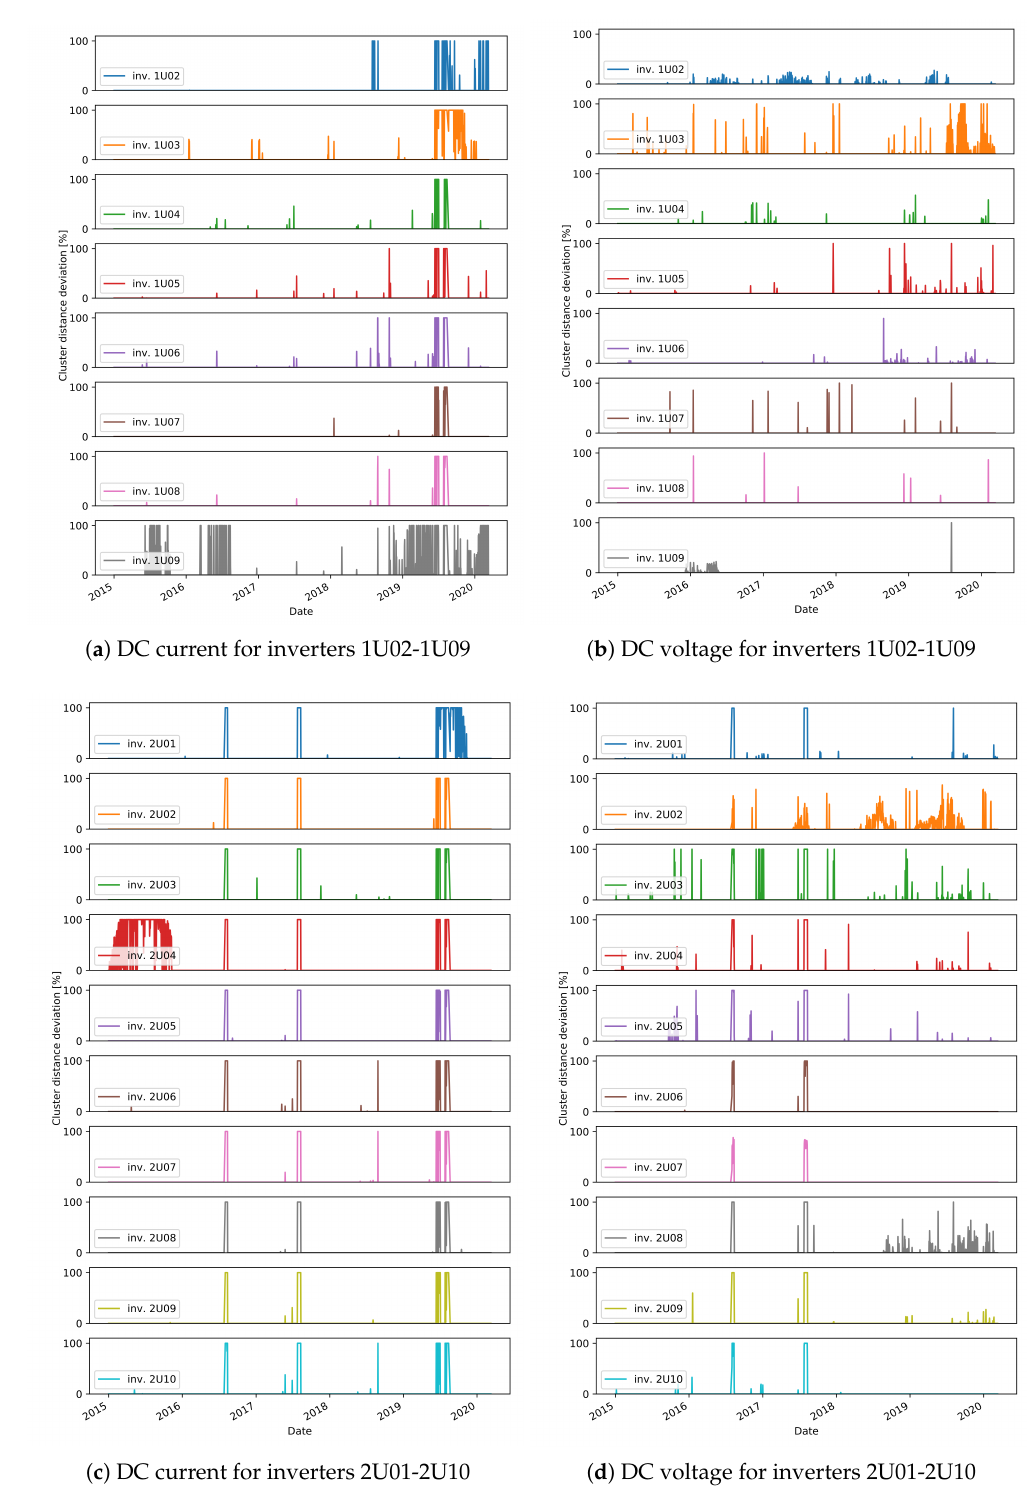
Figure 12. Unusual day event detection in plant